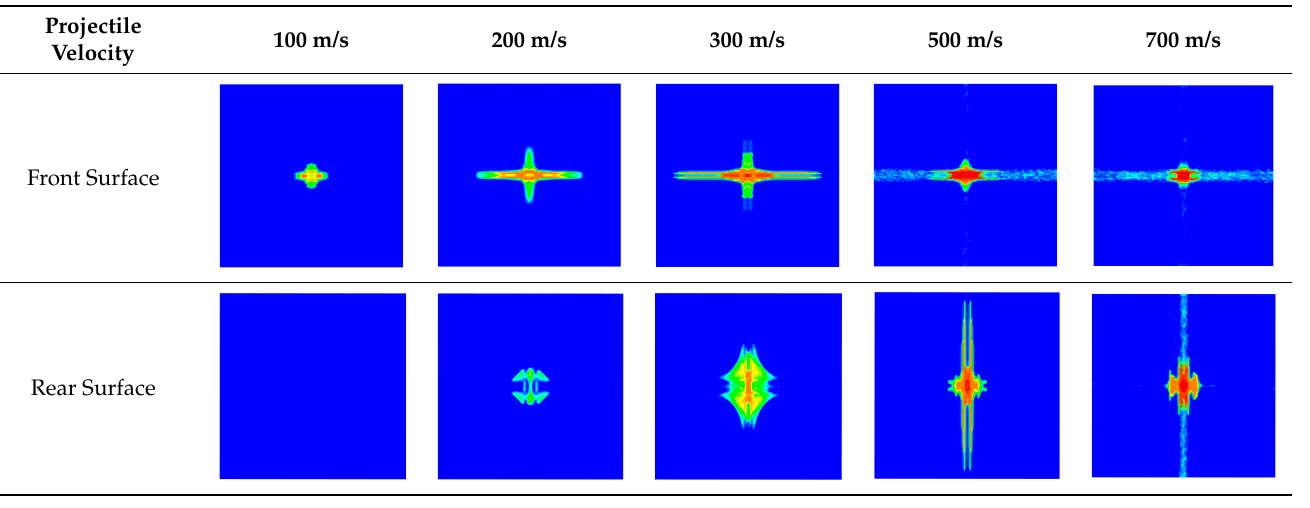
Table 5. Damage to the laminates subjected to different impact velocities.